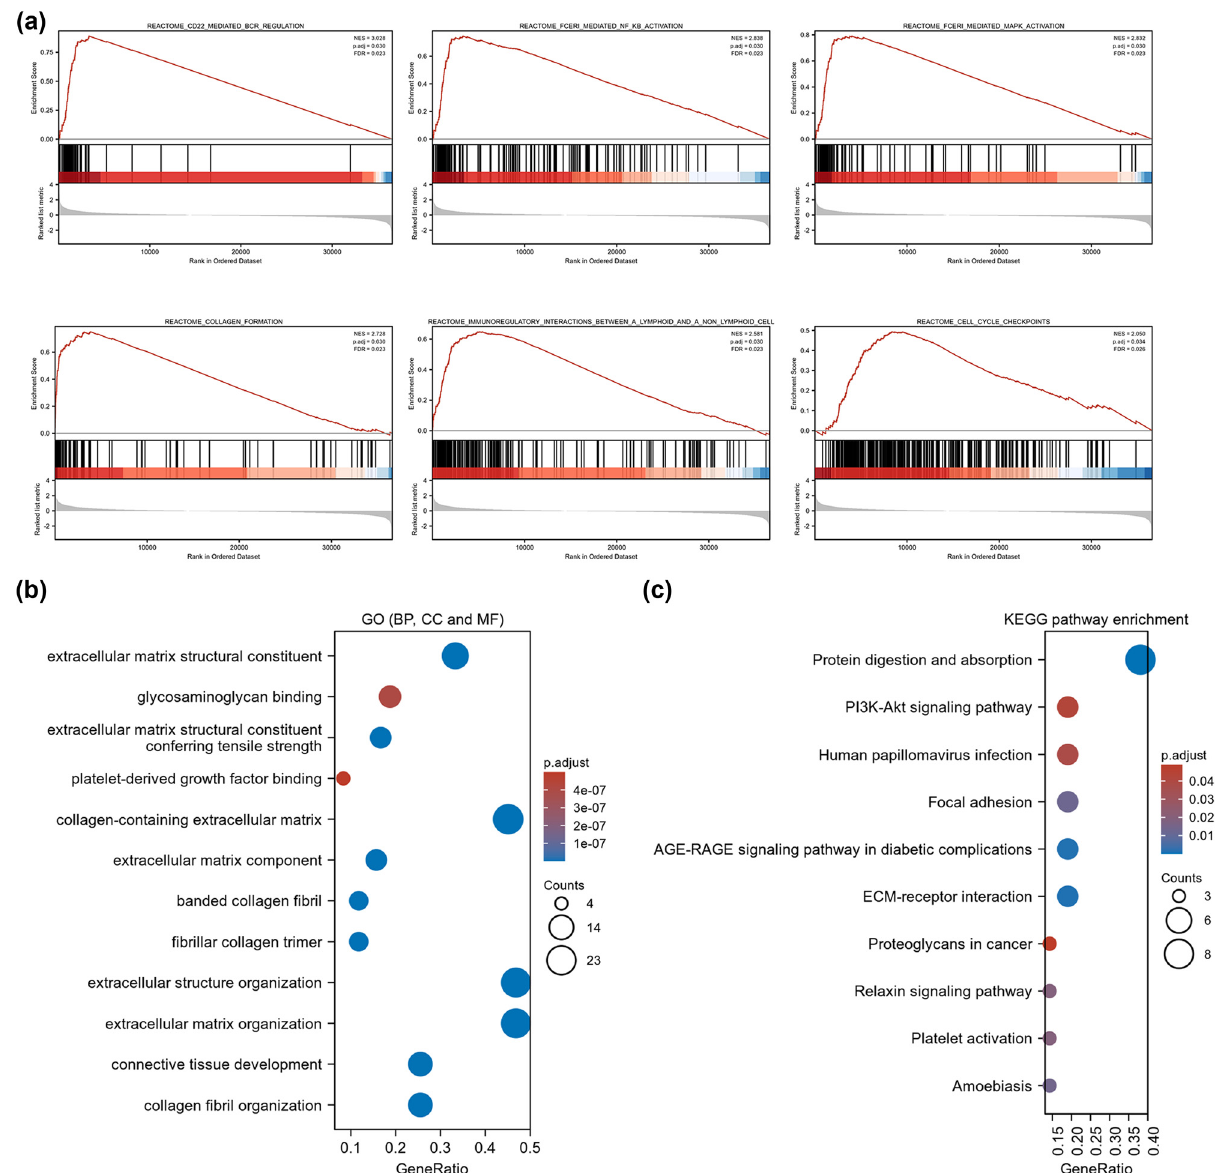
Figure 4: Assessment of GSEA, GO and KEGG in LUAD. GSEA was implemented using the TCGA database ( a ) . GO ( b ) and KEGG ( c ) were executed based on the top 50 related